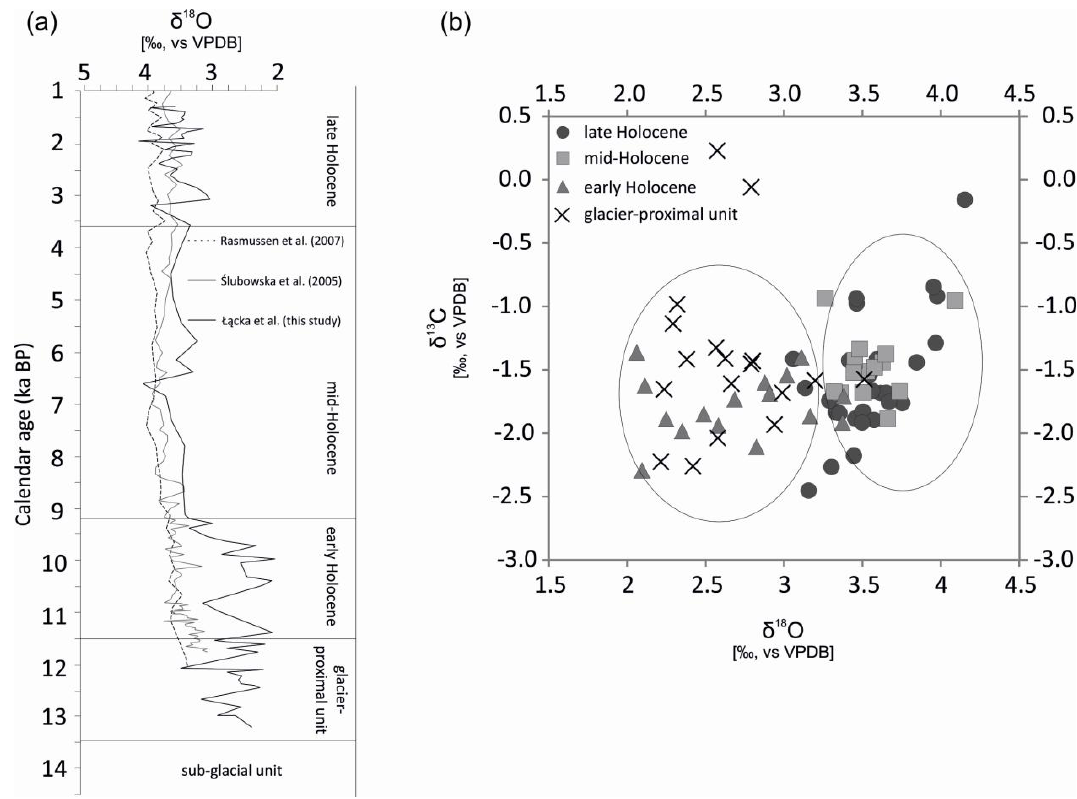
Figure 7. (a) The comparison of δ 18 O records (corrected for ice volume changes) between Ł ˛acka et al. (this study; black solid line) and ´Slubowska et al. (2005; grey solid line) and Rasmussen et al. (2007; black dashed line) plotted versus thousands of calendar years. The δ 18 O records after Ł ˛acka et al. (this study) were measured on E. excavatum f. clavata and the two latter ones (´Slubowska et al., 2005 and Rasmussen et al., 2007) were measured on M. barleeanum . (b) Scatter plot showing δ 13 C versus δ 18 O values from core JM09-020-GC (this